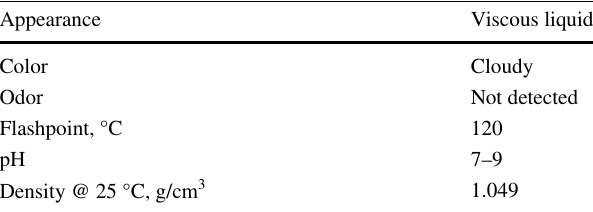
Table 3 Physical properties of demulsifier (Pasban et al.